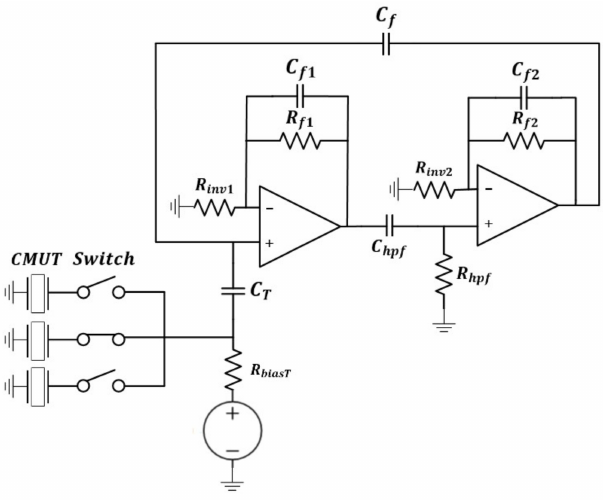
Figure 4. Schematic diagram of the Colpitts oscillator interfaced with three CMUT devices through an actively controlled